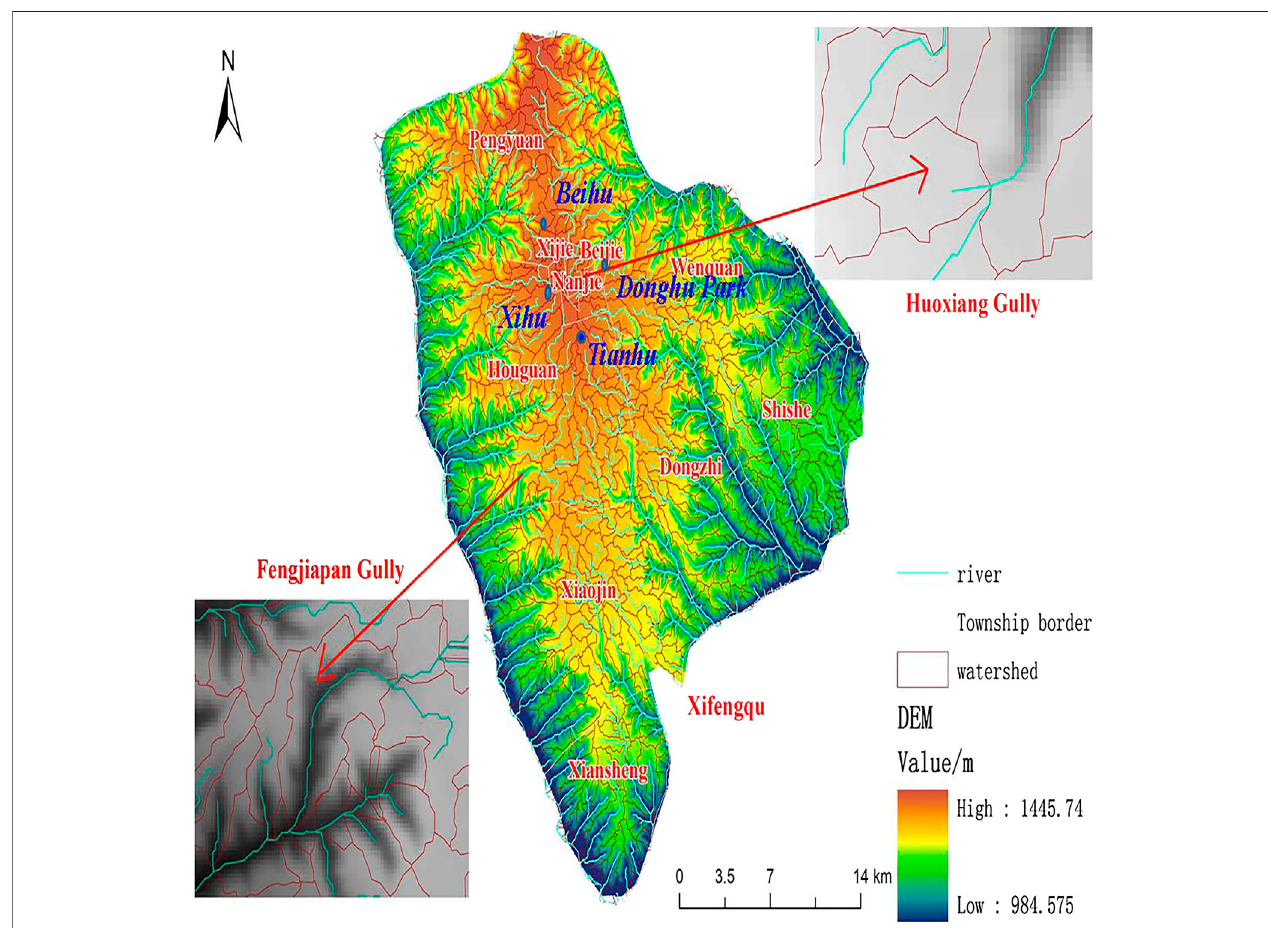
FIGURE 3 | Map showing the watershed in the Xifeng area.